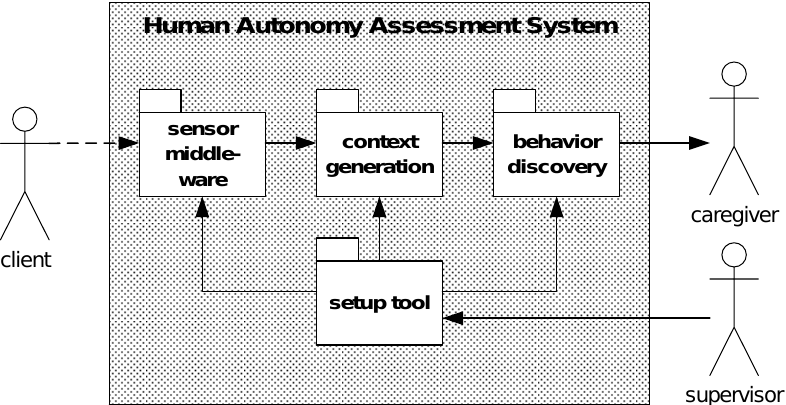
Figure 2. System process chain with four core modules (sensor middleware, context generation, behavior discovery and setup tool) and three roles (client, caregiver and